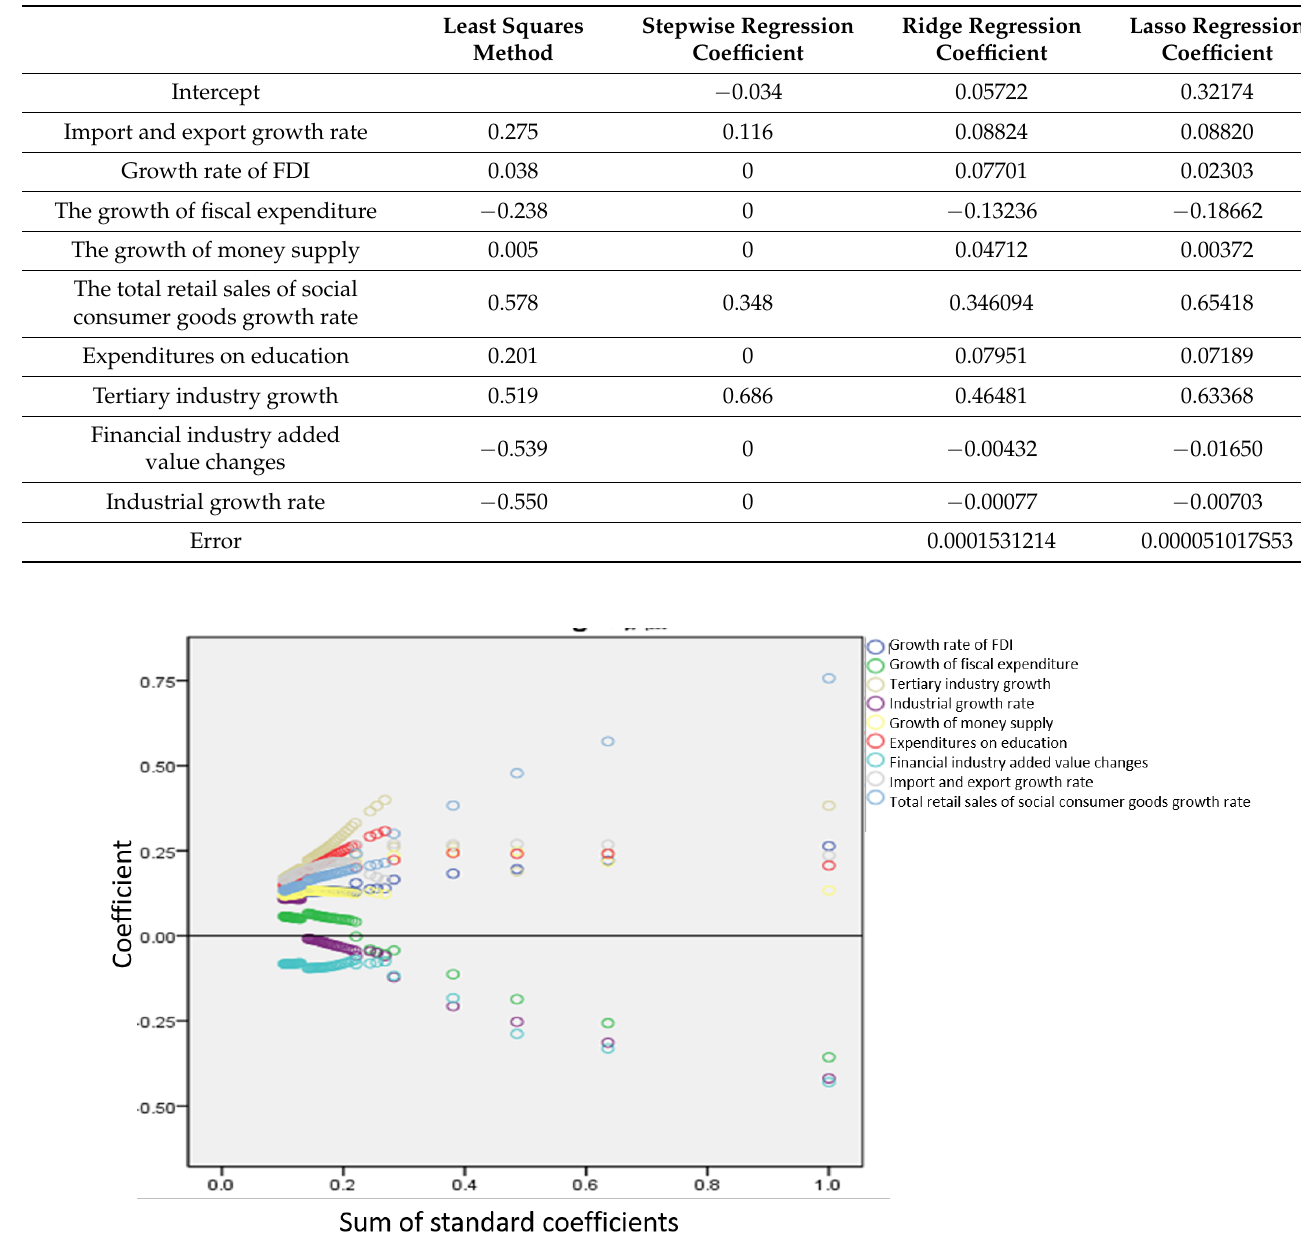
Figure 1. Path diagram of ridge regression.